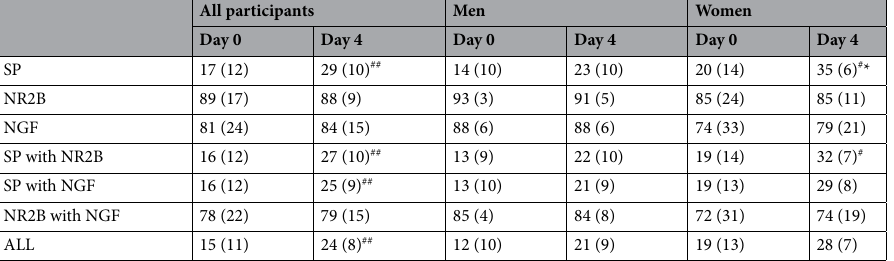
Table 2. The frequency (%) expression of nerve fibers associated with myocytes. The table presents the mean (SD) frequency of nerve fibers expressing markers alone and co-expressions (SP with NR2B, SP with NGF, NR2B with NGF, or All), from all participants, men, women on day 0 and 4. All = SP with NR2B and NGF. ## Significant differences between days in all participants (2-way RM ANOVA; P < 0.05). # Significant differences between days (Bonferroni; P < 0.05) within men or women. *Significant differences between men and women (Bonferroni; P < 0.05) within day 0 or day